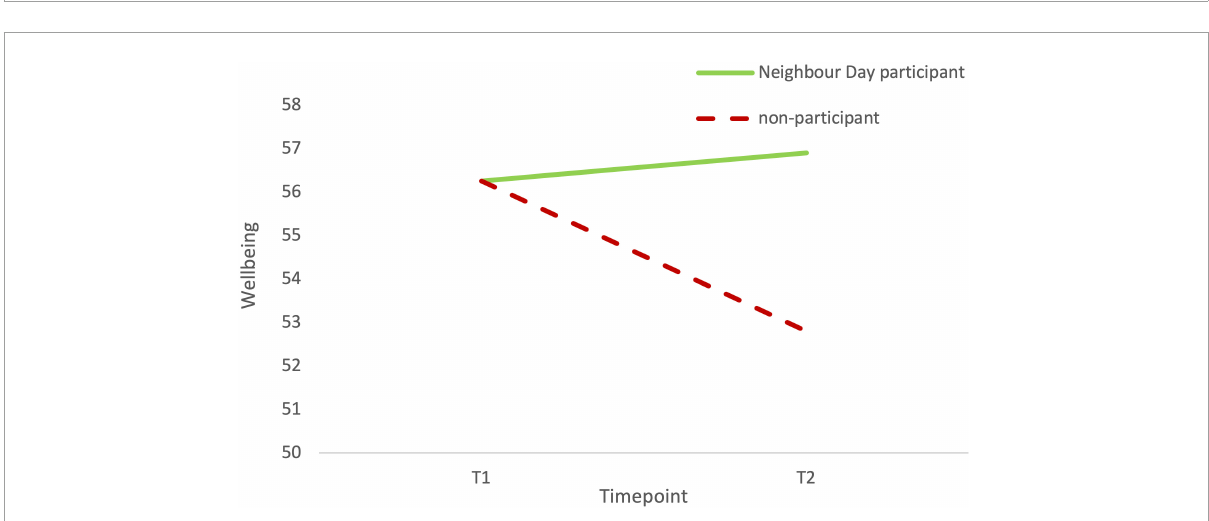
FIGURE4 Neighbour Day participants were protected against a decline in wellbeing between T1 and T2 that was significant in the sample overall. N = 440. The figures reproduced the estimated marginal means from a regression analysis including the covariates of wellbeing at T1, age, gender, relationship status, employment status, education, and neighbourhood socioeconomic